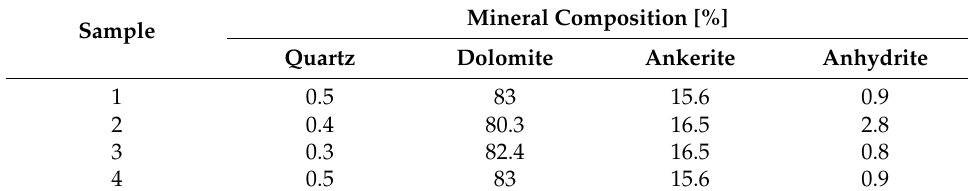
Table 3. Mineral composition of reservoir rock samples.